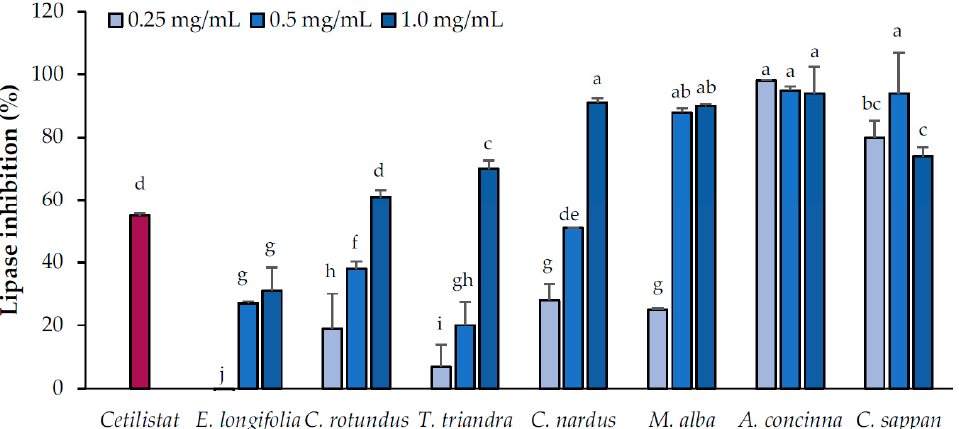
Figure 1. Pancreatic lipase-inhibitory activities of the candidate plant extracts. Cetilistat (positive control) concentration was 8 µM. Data are expressed as means ± standard deviation. Means with different letters are significantly different (Tukey’s test, p < 0.05).